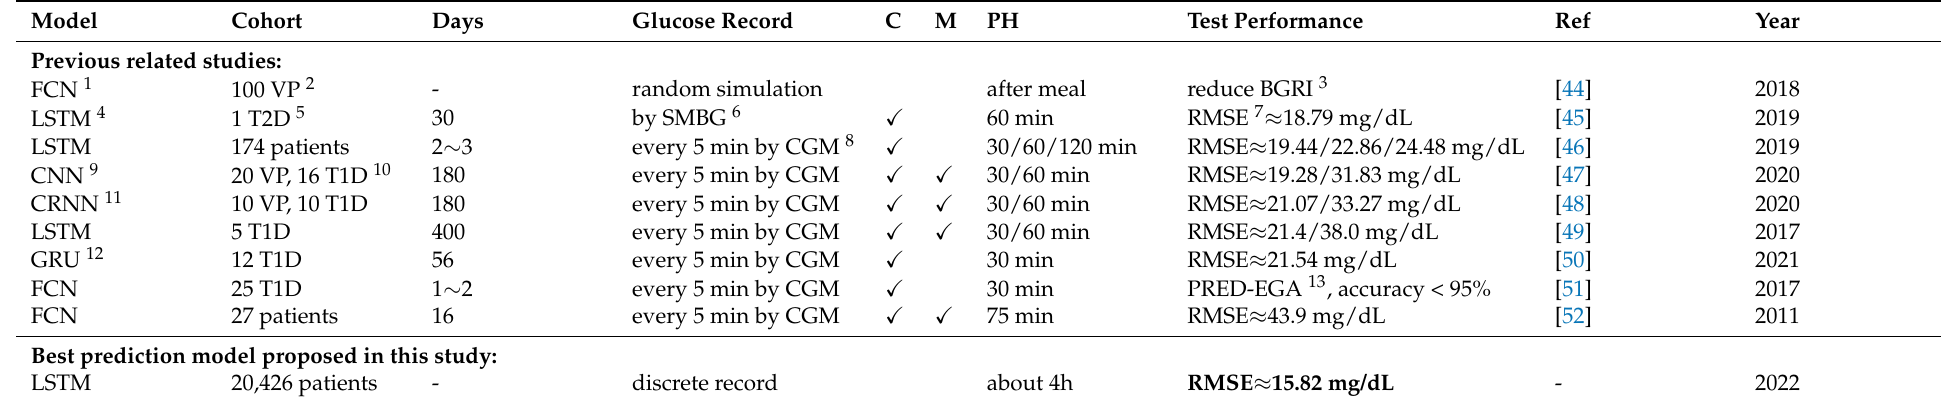
Table A1. Summary of previous studies addressing blood glucose prediction using deep nueral networks: model type, number of participants in the cohort, mean number of monitored days per patient, methods and frequency of blood glucose monitoring, whether continuous recording is required (C), whether manual record is required (M), prediction horizon (PH), test performance of the model, citation and publish year.